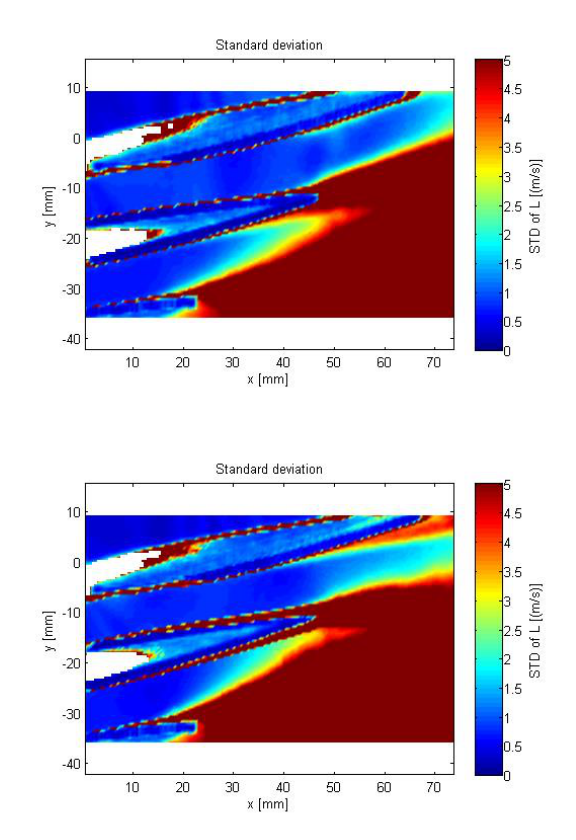
Fig. 11a, b, c, d. Mean phase velocity distribution and its STD value for excited regime (40 Hz and φ = 180° ) for turbine